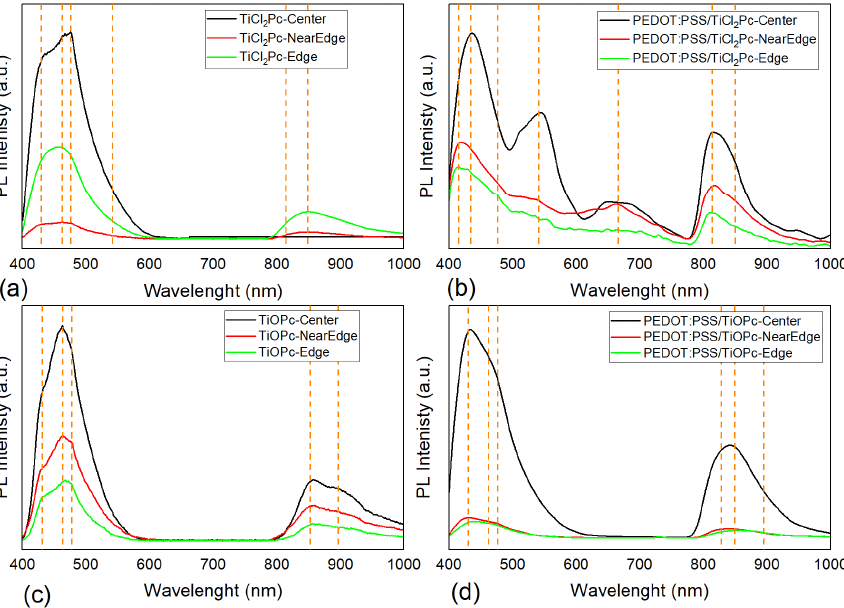
Figure 8. PL spectra of ( a ) TiCl 2 Pc and ( b ) PEDOT:PSS/TiCl 2 Pc and ( c ) TiOPc and ( d ) PE- DOT:PSS/TiOPc films.